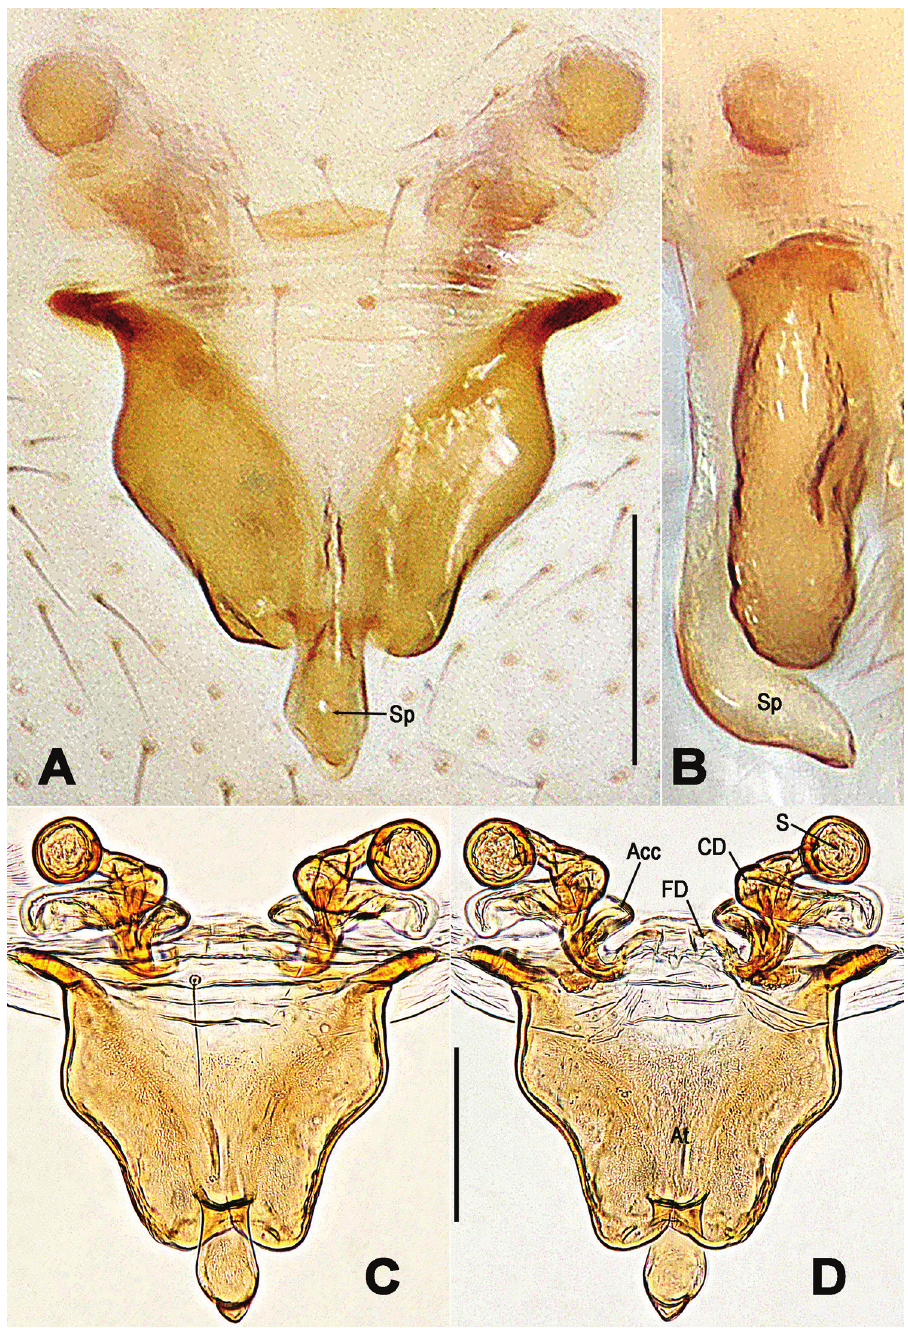
Figure 11. Trogloneta yunnanense (Song & Zhu, 1994) comb. n., female epigyne ( A, B ) and vulva ( C, D , lactic acid-treated). A, C ventral B lateral D dorsal. Abbreviations: Acc accessory gland; At atrium; CD copulatory ducts; FD fertilization ducts; S spermathecae; Sp scape. Scale bars: 0.20